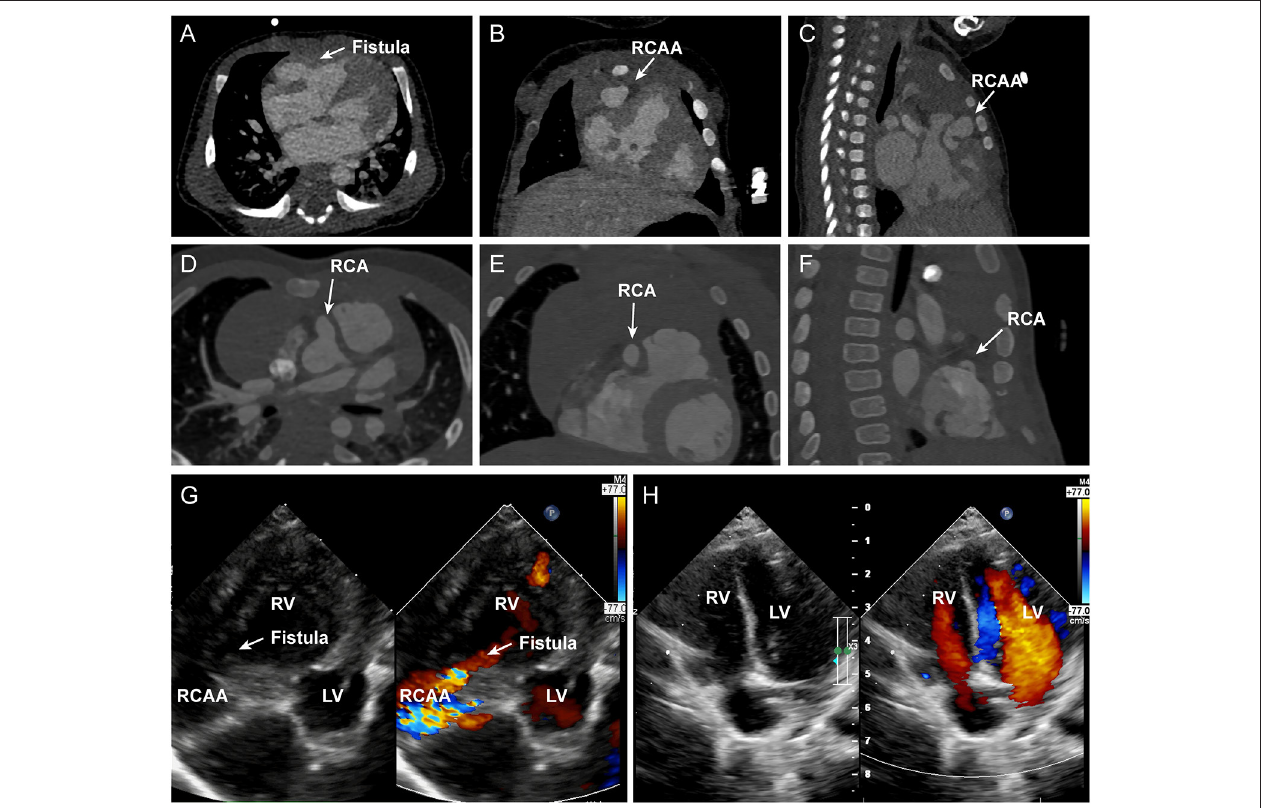
FIGURE 1 | (A–C) depict the axial, coronal, and sagittal panel of the preoperative CTA, respectively. The white arrows indicated the fistula and RCAA. (D–F) depict the axial, coronal, and sagittal panel of the 6-months follow-up CTA, respectively. The white arrows indicate the mild dilated RCA. (G,H) show the preoperative and postoperative echocardiography images of the patient. A large fistula and RCCA to RV shunt was indicated by the arrow. RCA, right coronary artery; RCAA, right coronary artery aneurysm; LV, left ventricle; RV, right